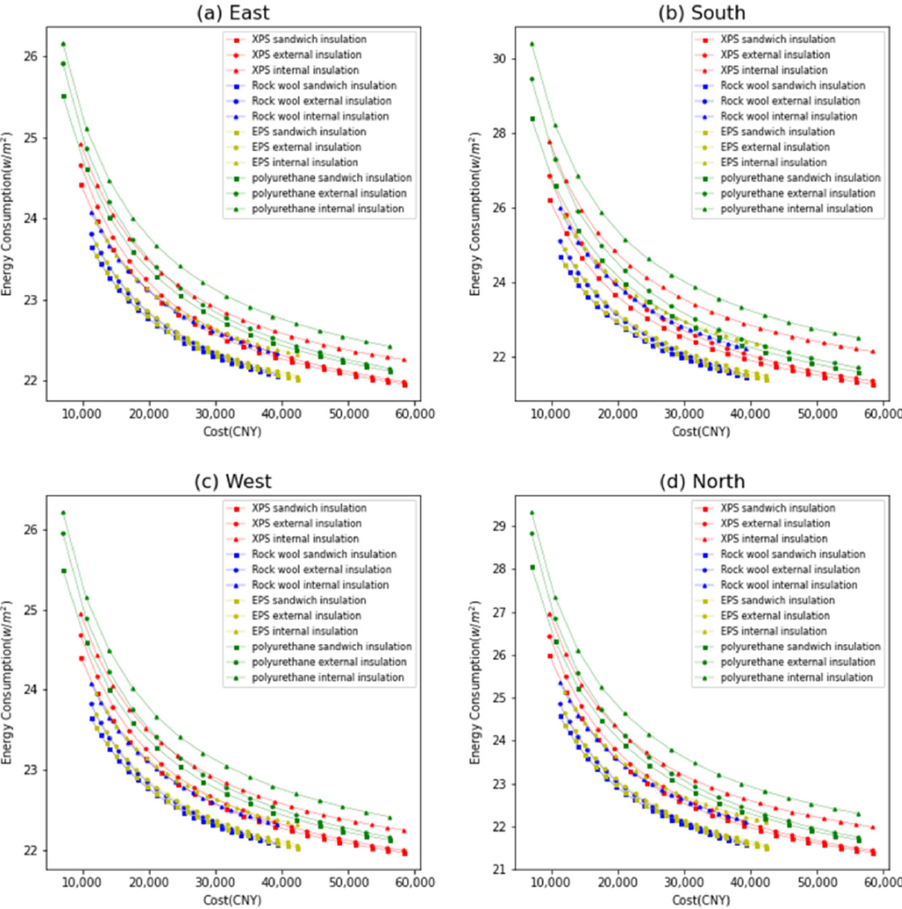
Figure 6. Energy consumption and cost charts of various orientations and different insulation ma-